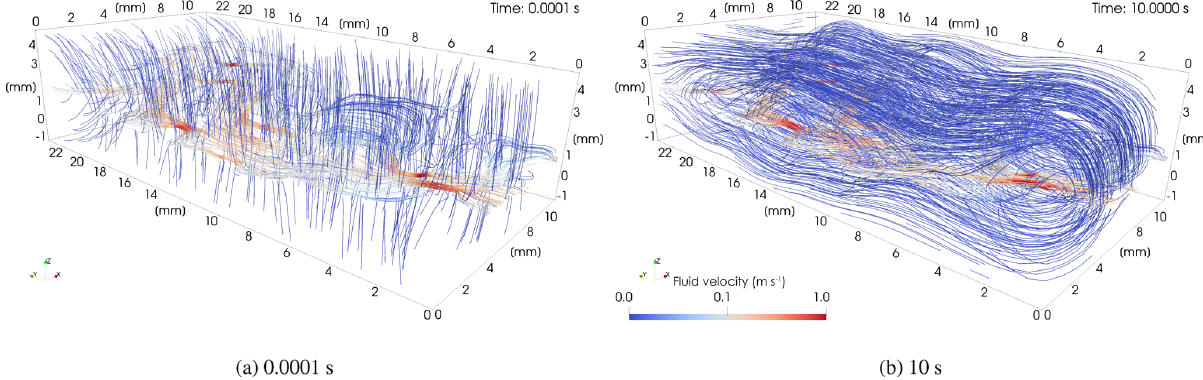
Figure 6. Velocity field in the matrix-fracture system after 0.0001 (a) and 10s (b) of inflow,